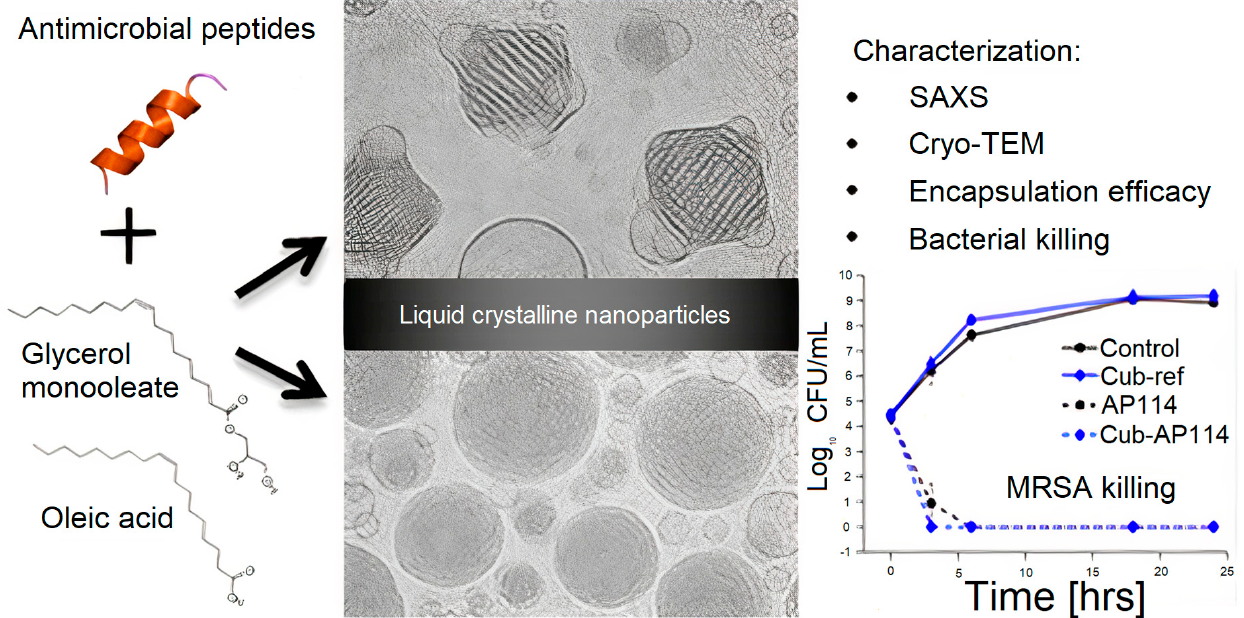
Figure 6. Lyotropic liquid − crystalline (LC) nanoparticles (NPs) tested as carriers for AMPs. Reproduced with permission from [105]. Copyright 2016 American Chemical Society.